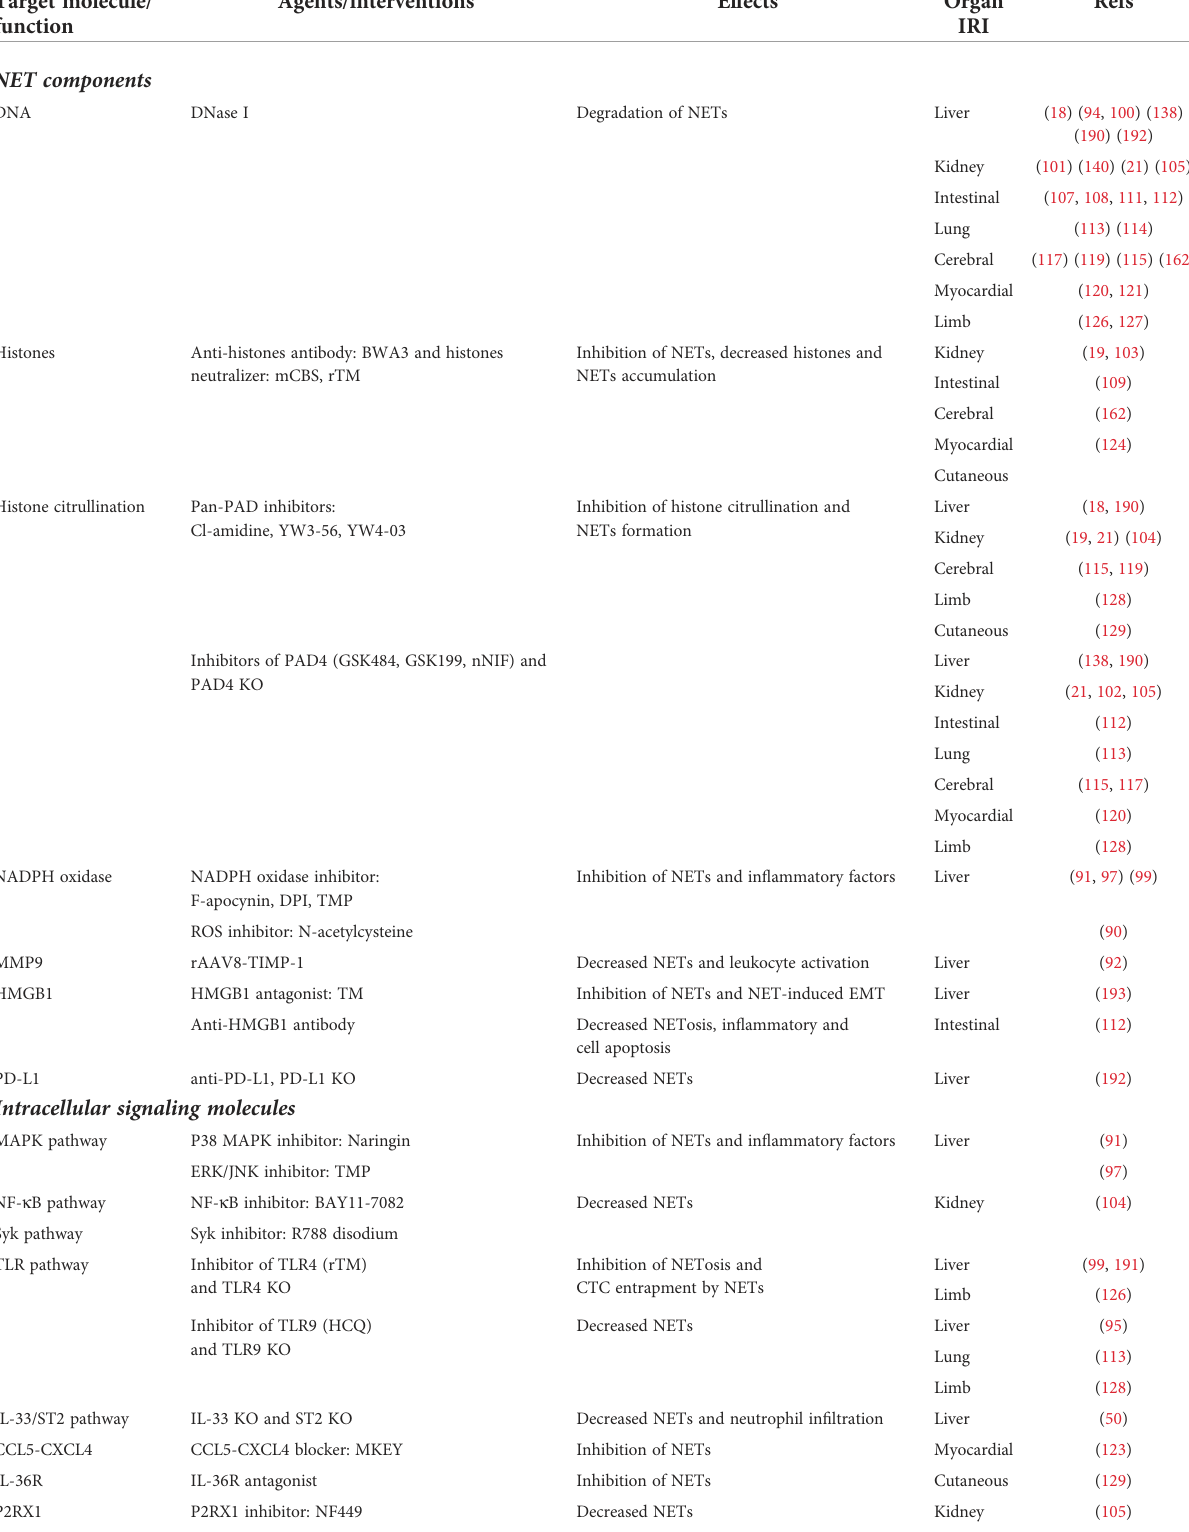
TABLE 2 Targeted anti-extracellular trap interventions to improve outcomes of organ